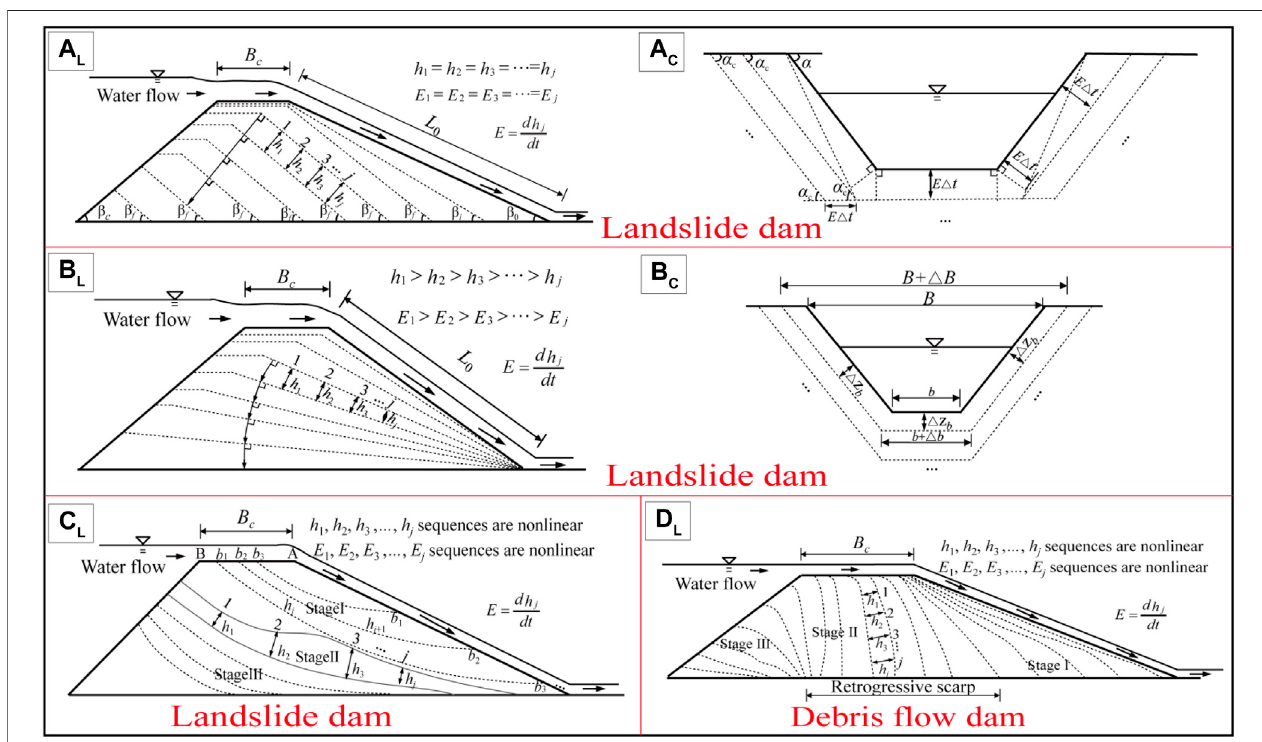
FIGURE 8 | Evolution models of the breach of the barrier dam. (A) Evolution model of the breach of the landslide dam proposed by Chang and Zhang (2010) (modi fi ed). (B) Evolution model of the breach of the landslide dam proposed by Zhong et al. (2017) (modi fi ed). (C) Evolution model of the breach of the landslide dam proposedbyZhouG.G.D.etal.(2019)(modi fi ed). (D) Evolutionmodelofthebreachofthedebris- fl owdamproposedbyRuanetal.(2021)(modi fi ed).Thesubscript “ L ” in the fi gure number represents the “ longitudinal evolution of the breach ” and “ V ” represents the “ cross evolution of the breach ” .